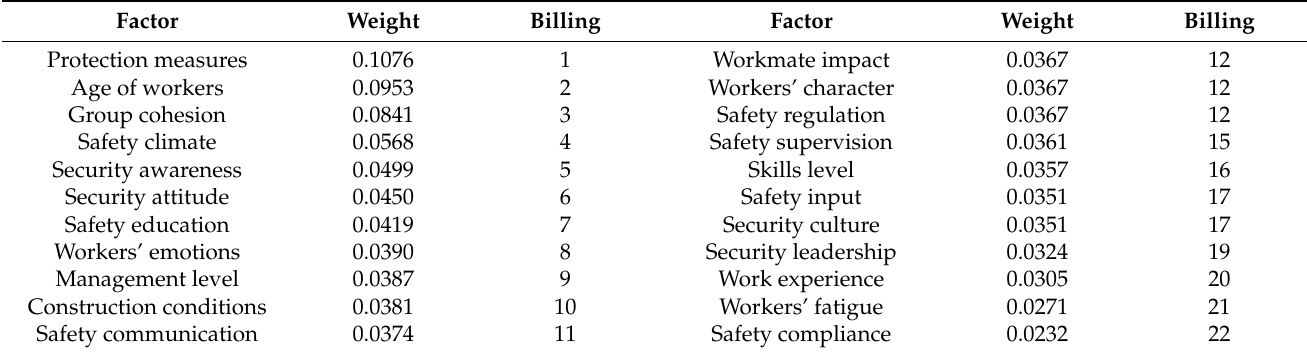
Table 8. The weight of influencing